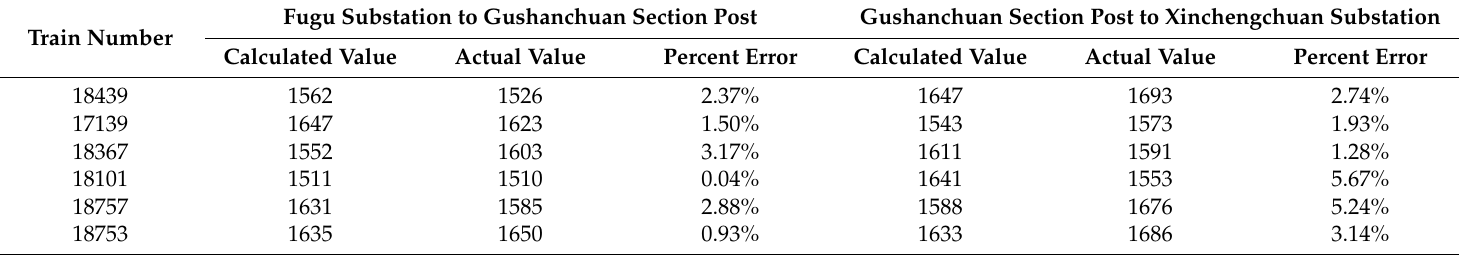
Table 7. Verification results of energy consumption of DC trains in the downhill